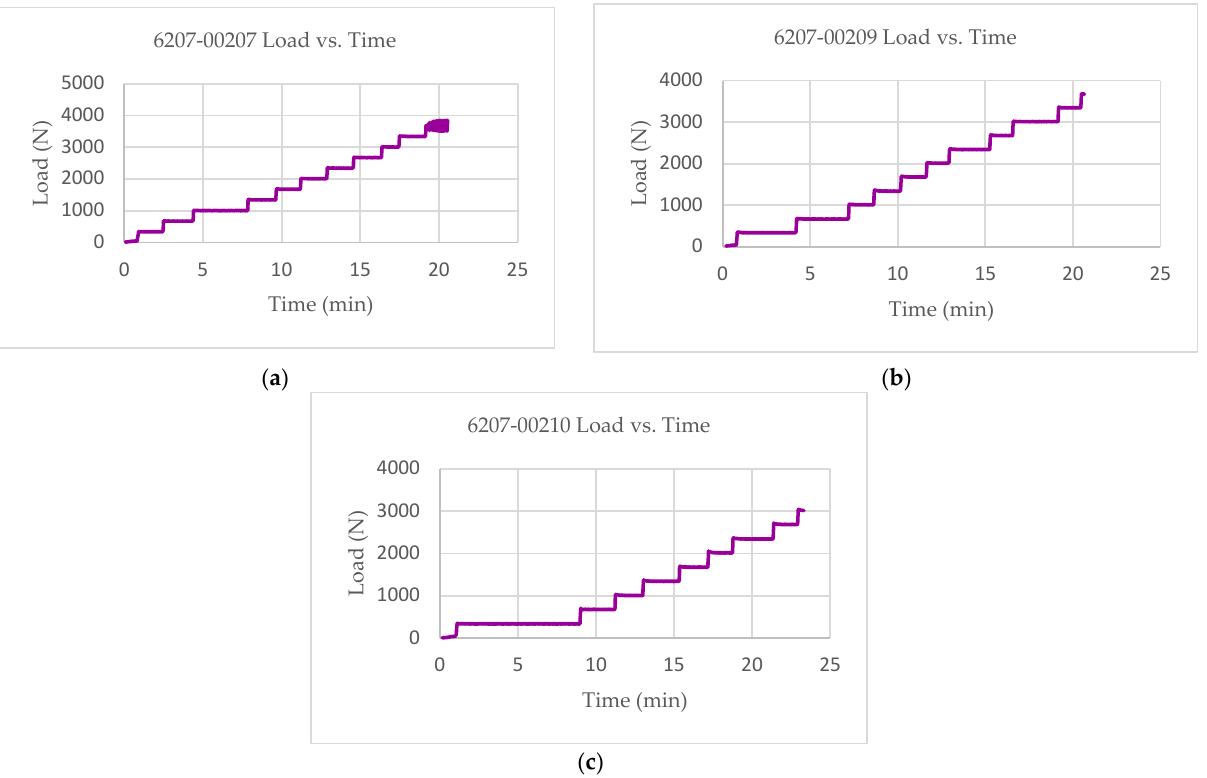
Figure 7. Load–time behavior of multifunctional test coupons at RTD: ( a ) 6207 ‐ 00207; ( b ) 6207 ‐ 00209; ( c ) 6207 ‐ 00210.